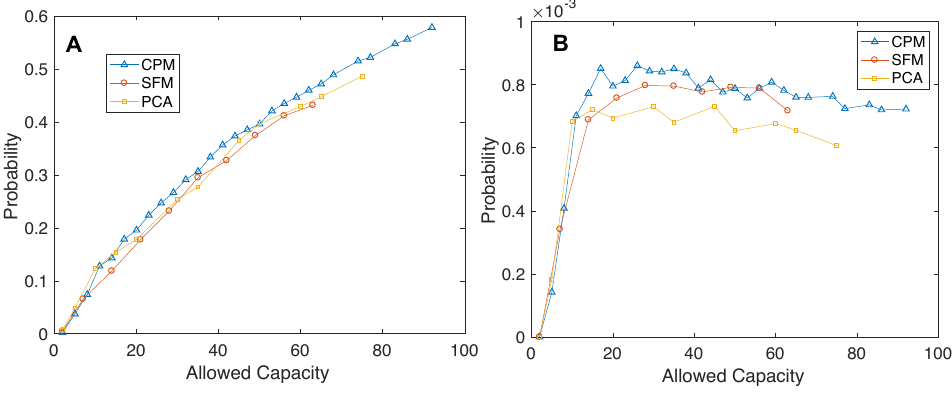
Figure 7: A: Probability of having the first neighbor closer than 2 m (Eq. (10)). B: Probability that a given pair of agents are within 2 m of one another (Eq.